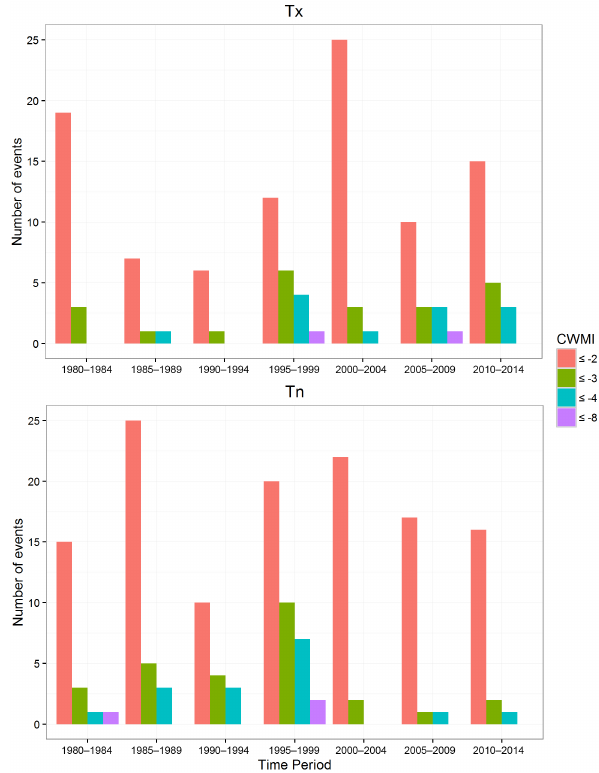
Figure 6. Histogram of cold waves for 5-year periods during 1980– 2014 for maximum temperature ( T x , upper panel) and minimum temperature ( T n , bottom